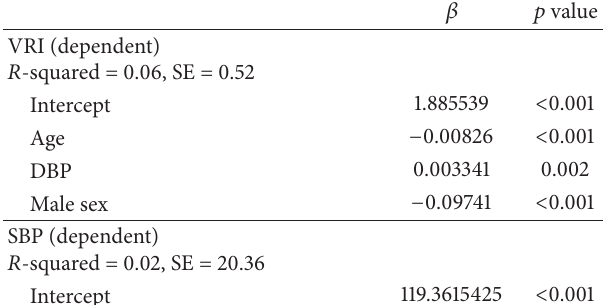
Figure 3: Vascular reactivity index (VRI) and age. A scatter plot, trend line, and Pearson’s 𝑟 coefficient are shown. VRI was mildly and inversely correlated with age.